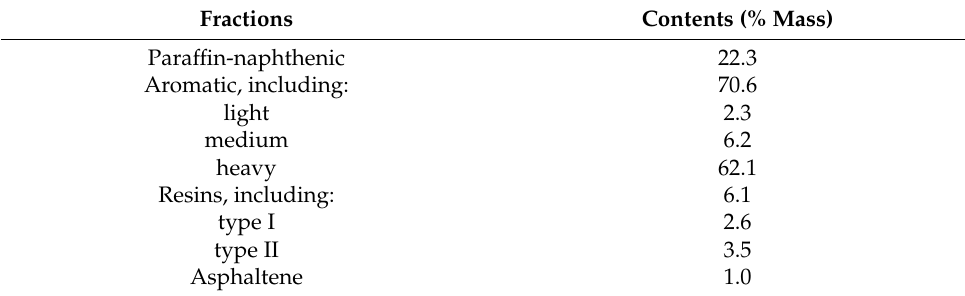
Table 2. Group hydrocarbon content of original